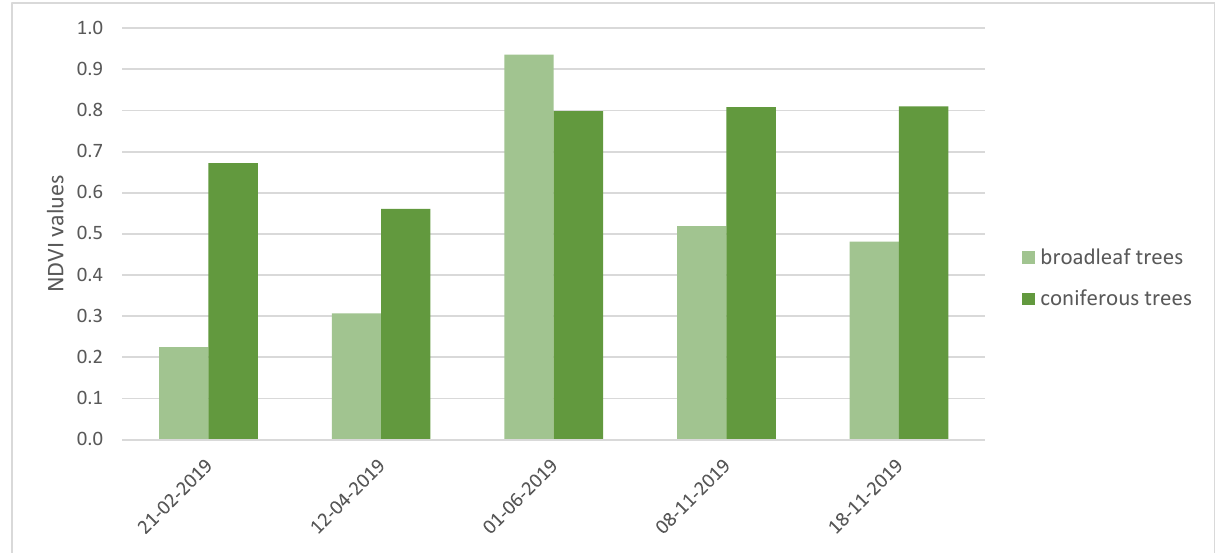
Figure 6. Coniferous and broadleaves samples NDVI signature over 5 periods of the year. (ii) Classification over the whole area Using the NDVI signatures derived in the previous section, it was possible to derive, inside the 2019 forest mask, the discrimination between broadleaved and coniferous trees. Using several observations allowed the reduction in artefacts that could derive from shad- ows. Given the very limited area covered by coniferous species, the quality of the Forest Type map was assessed by means of visual interpretation over reference field data pro- vided by UNDP Armenia. (iii) Crossing with Forest Density to derive Broadleaved and Coniferous Density Once the coniferous/broadleaf layer was produced, it was possible to combine it with the Forest Density 2019 product to derive the Broadleaved and Coniferous Density prod- ucts, with the following nomenclature: